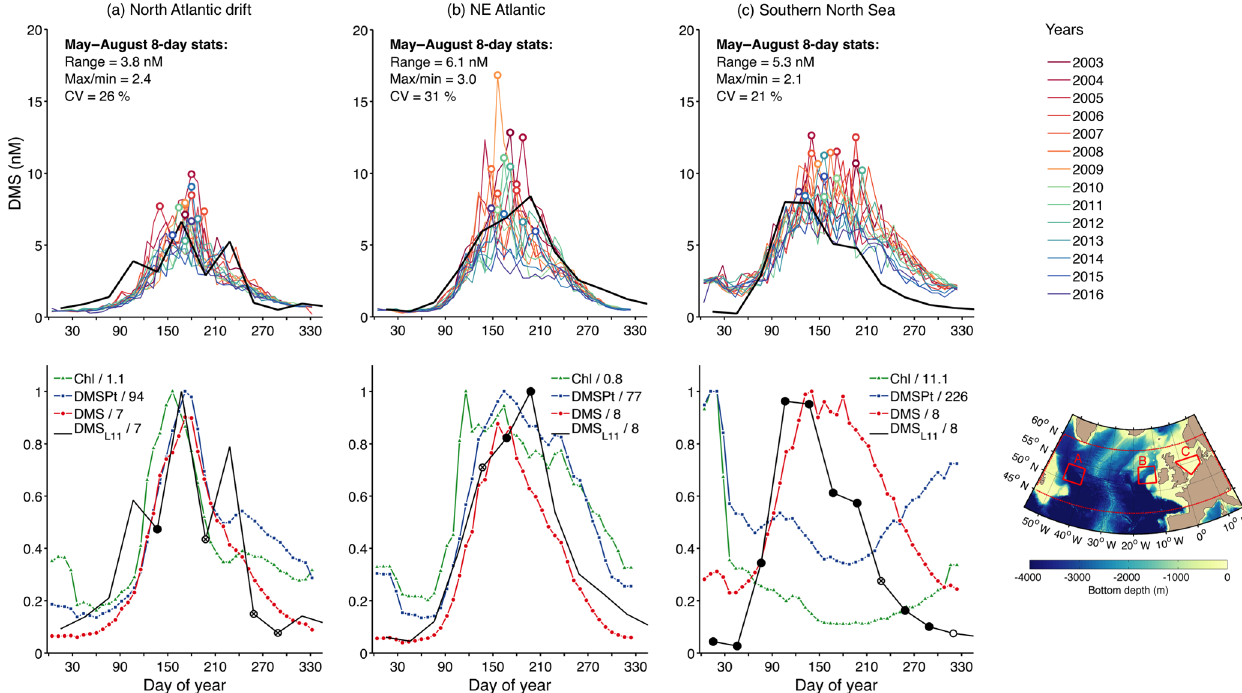
Figure 8. Interannual DMS SAT variability in the subpolar North Atlantic. (a) Northwest Atlantic drift, (b) shelf break west of Ireland, (c) southern North Sea shelf. Top panels show individual years between 2003 and 2016 determined from 8-day MODIS-Aqua data, dif- ferentiated by color, and the mean seasonal cycle according to the L11 DMS climatology (black); colored circles mark the peak of each seasonal cycle. Bottom panels show the mean annual cycles of Chl SAT , DMSPt SAT , DMS SAT and the L11 DMS climatology. Each variable is divided by its maximum, shown by the number in the quotient; a common scaling factor is used for DMS SAT and DMS L11 . Markers on the L11 line indicate the amount of in situ data on which the L11 climatology is based in a given month: no data, i.e., month filled through interpolation (no marker); 1–9 measurements in a single year (empty circles); ≥ 10 measurements in a single year (crossed circles); and ≥ 10 measurements distributed in different years (filled black circles). Red polygons on the map show the 3 selected areas and the larger region used for the validation scatter plots (see Fig.